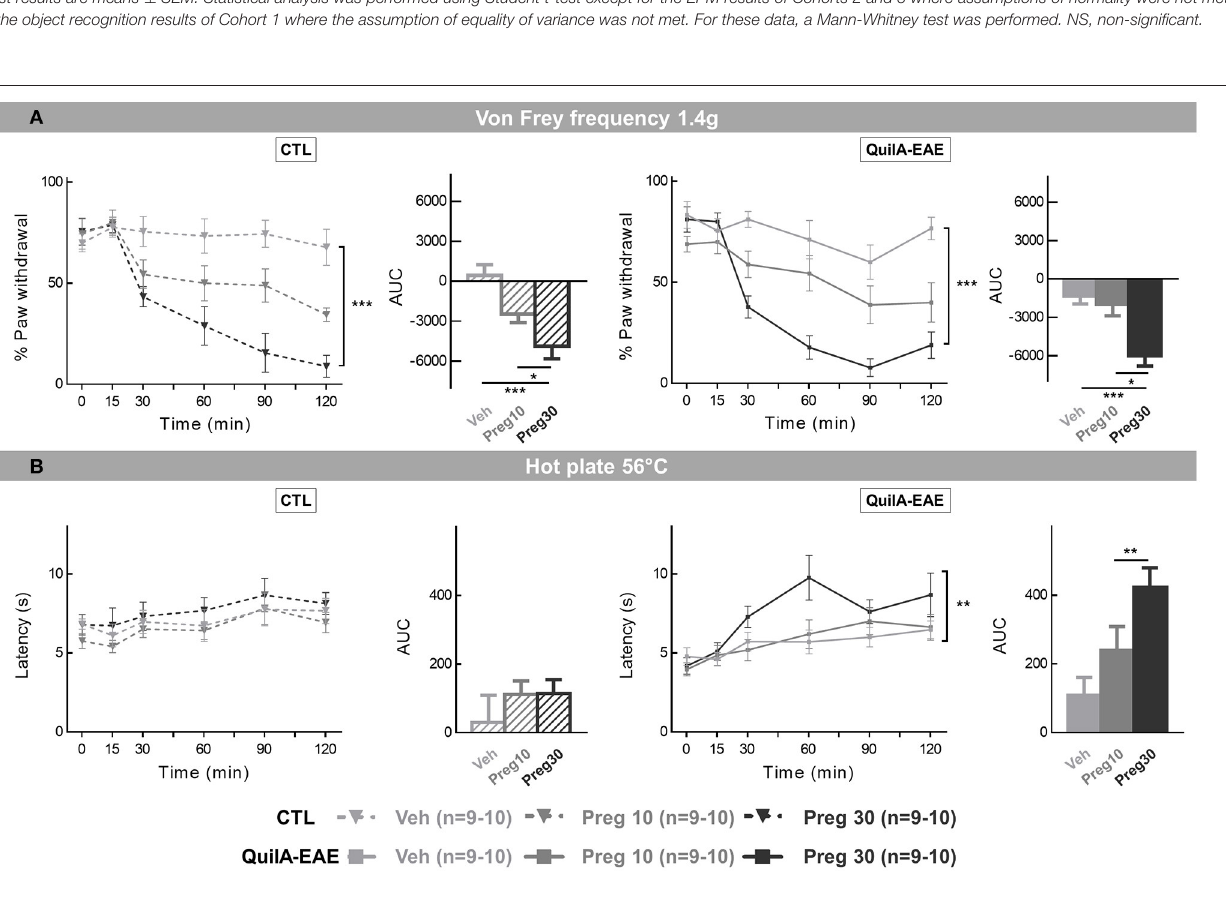
FIGURE 6 | Pharmacological evaluation of pregabalin effects on mechanical sensitivity and heat hyperalgesia in mice immunized with MOG 35 − 55 (QuilA-EAE) and their controls (CTL) during the chronic phase of the disease. Mice received a single intraperitoneal (i.p.) bolus dose of pregabalin at 10 or 30 mg/kg or vehicle (NaCl sterile for injection). (A) Mechanical sensitivity assessed by the von Frey frequency method using calibrated 1.4g von Frey hair filaments. Measurements were made before injection and for 2h after injection and expressed as the mean percentage of paw withdrawal ± SEM. Results are represented as time course curves for each group and as areas under the curve (AUC) calculated for each group and represented by a bar chart. Data for CTL mice are given on the left and data of QuilA-EAE mice on the right. (B) Heat hyperalgesia evaluated by a hotplate test at 56 ◦ C. Measurements were made before injection and 2h after injection and expressed as the mean latency of the first nocifensive behavior ± SEM. Results are represented as a time course curve for each group and as area under the curve (AUC) calculated for each group and represented by a bar chart. Data of CTL mice are given on the left, data of QuilA-EAE mice on the right. For AUC, statistical analysis was performed